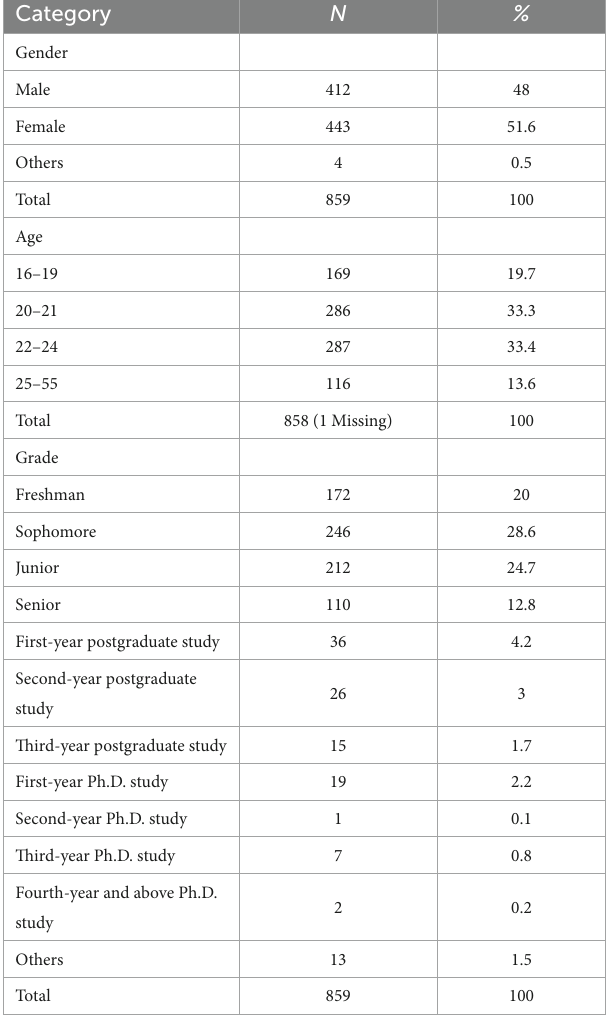
TABLE 1 Demographic information of the